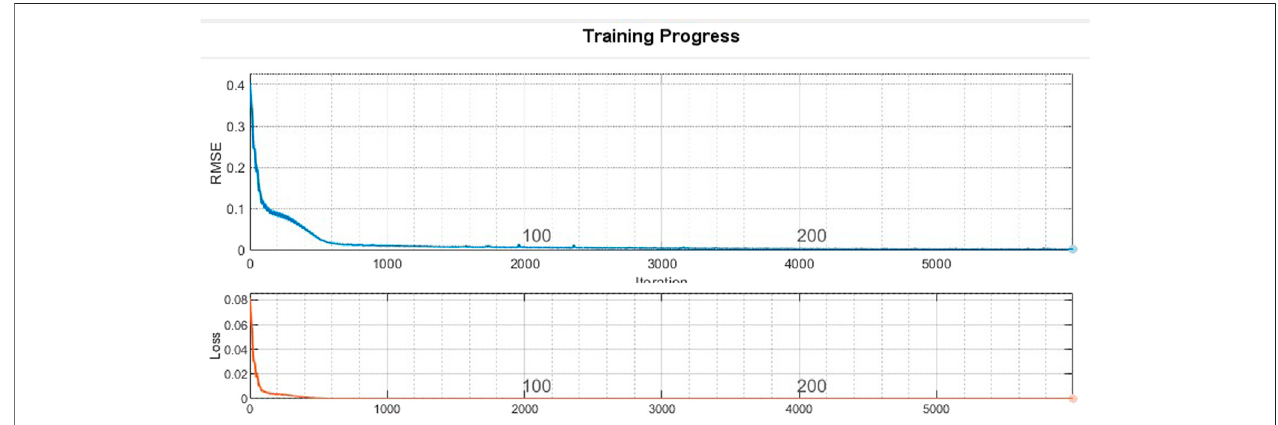
FIGURE7| LearningprocessofLSTMmodel,wheretherootmeansquarederror(RMSE)istheerrorbetweenthepredictedvalueandtruevalue,andthelossisthe changes in the loss function during the iteration process.